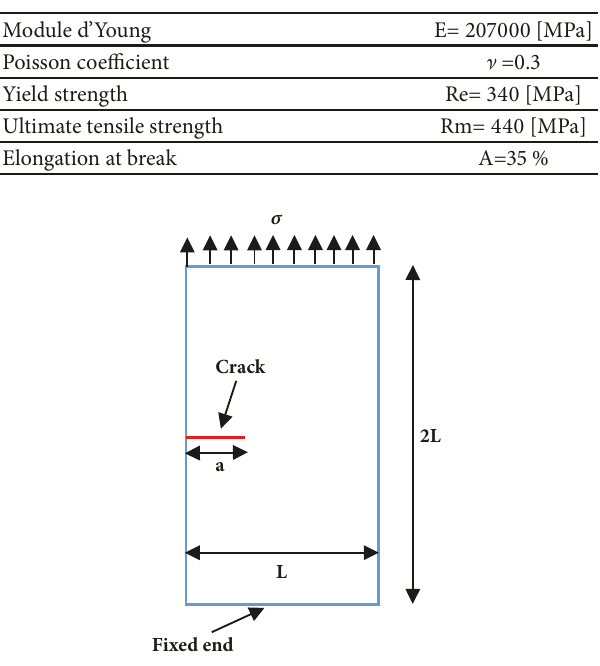
Figure 2: A two-dimensional plate with an axial